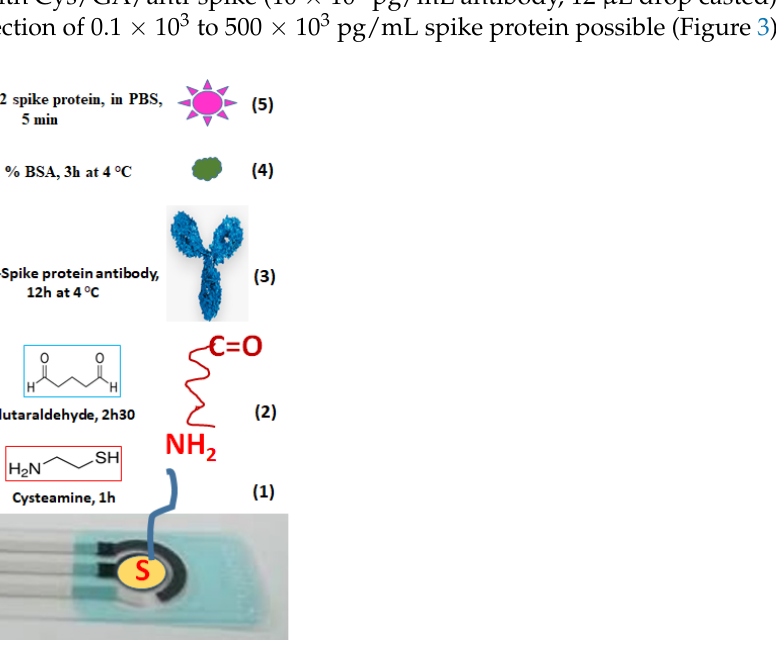
Figure 3. Functionalization of working electrode with AuNPs (yellow circle) and different chemicals cysteamine (1), glutaraldehyde (2), anti-spike protein antibody (3), BSA blocking reagent (4) and SARS-CoV-2 spike protein (5).